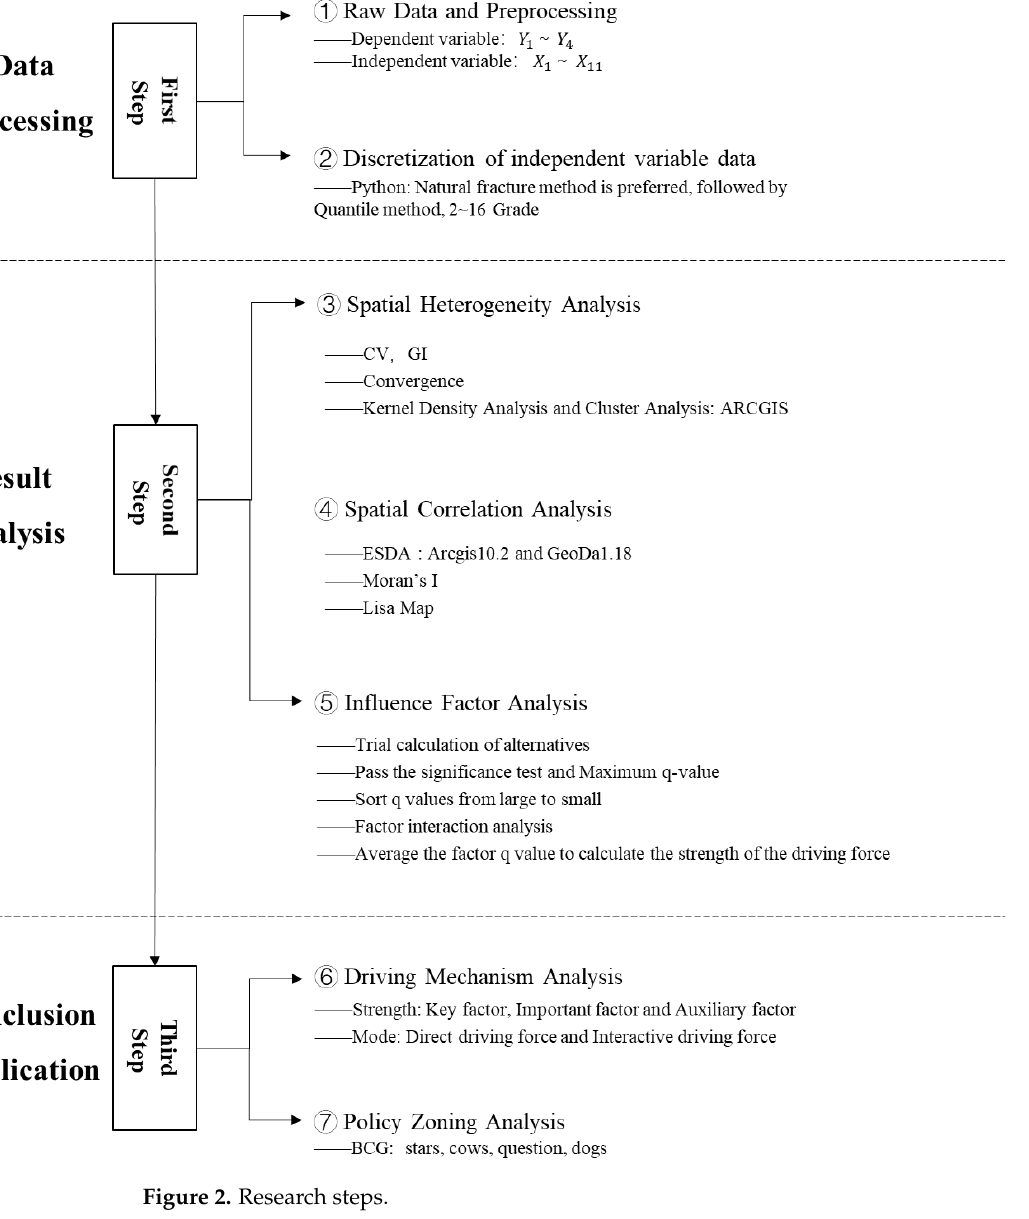
Figure 2. Research steps